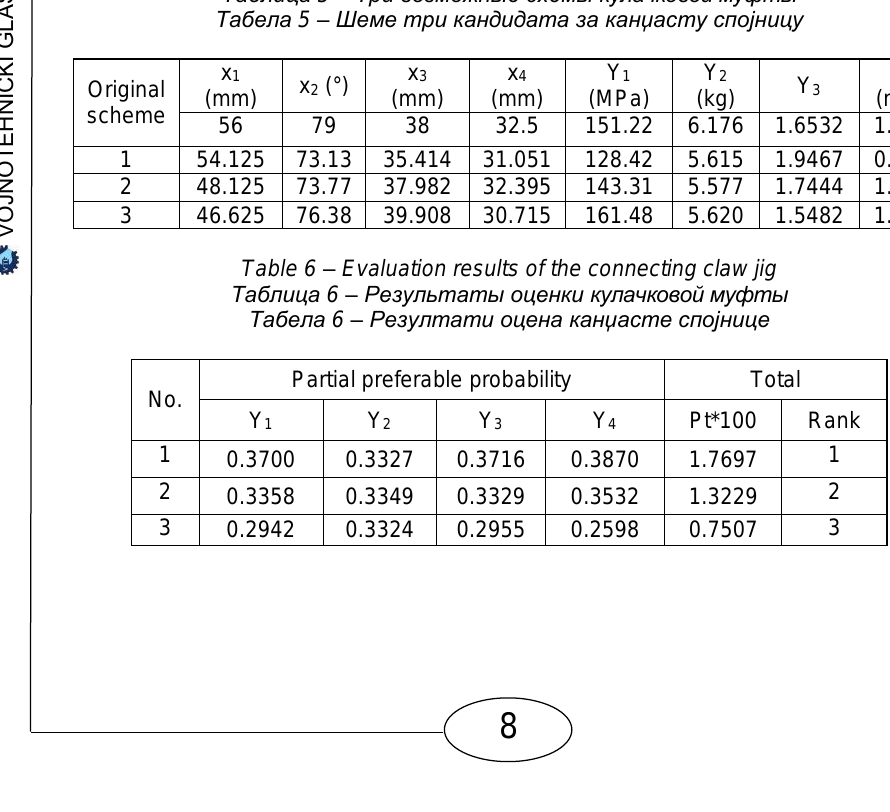
Table 5 – Three candidate schemes of the connecting claw jig